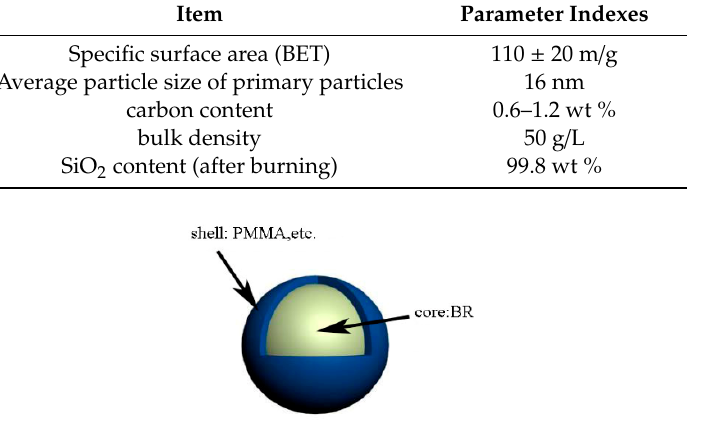
Figure 1. Structure of CSR particle.